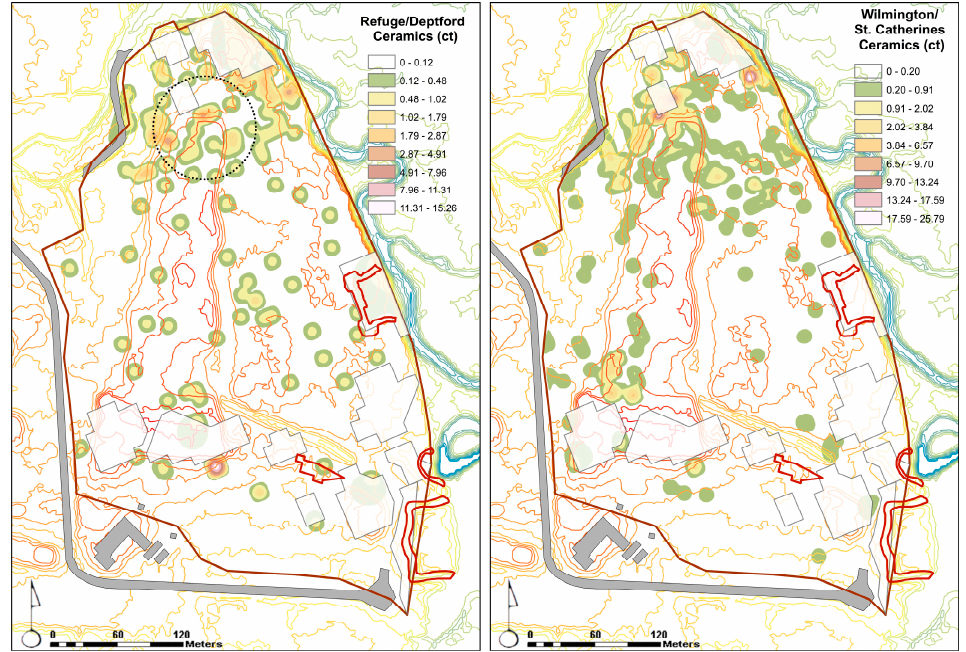
Figure 6. The distribution of Refuge/Deptford period ( left ) and Wilmington/St. Catherine’s period ( right ) ceramics recorded through a shovel test survey. Circular pattern referenced in the text is indicated by a dashed circle. Areas whited-out were not shovel tested. Contour spacing is 1m. Contours are based on the LiDAR dataset and use the NAD 1983 and NAV 1988 horizontal and vertical datum, respectively.